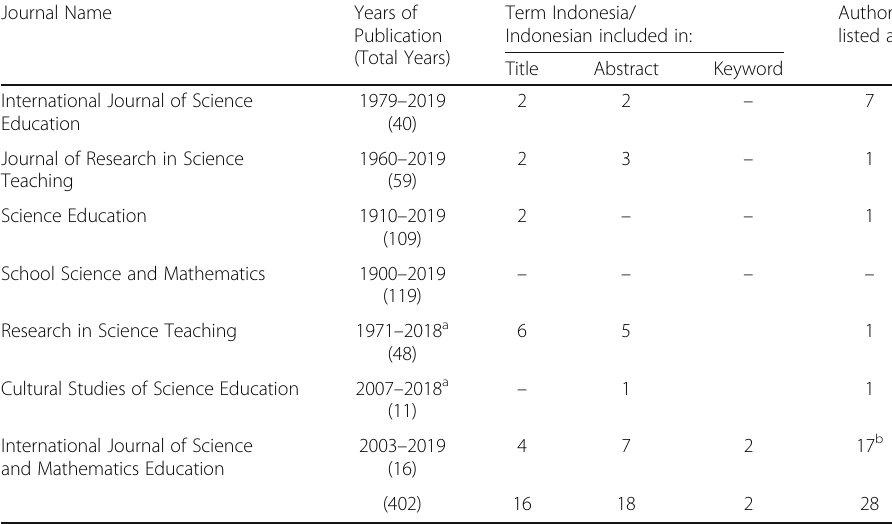
Table 8 Analysis of publications in top science education journals related to